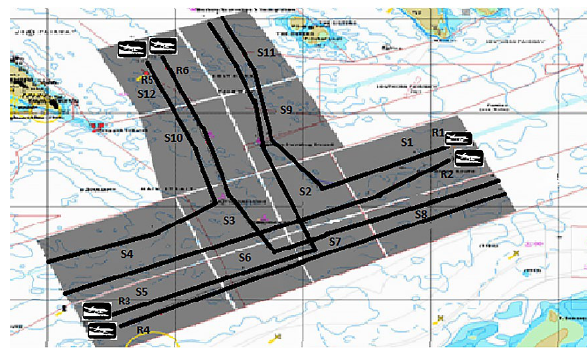
Figure 3. Sectors within the Singapore Strait